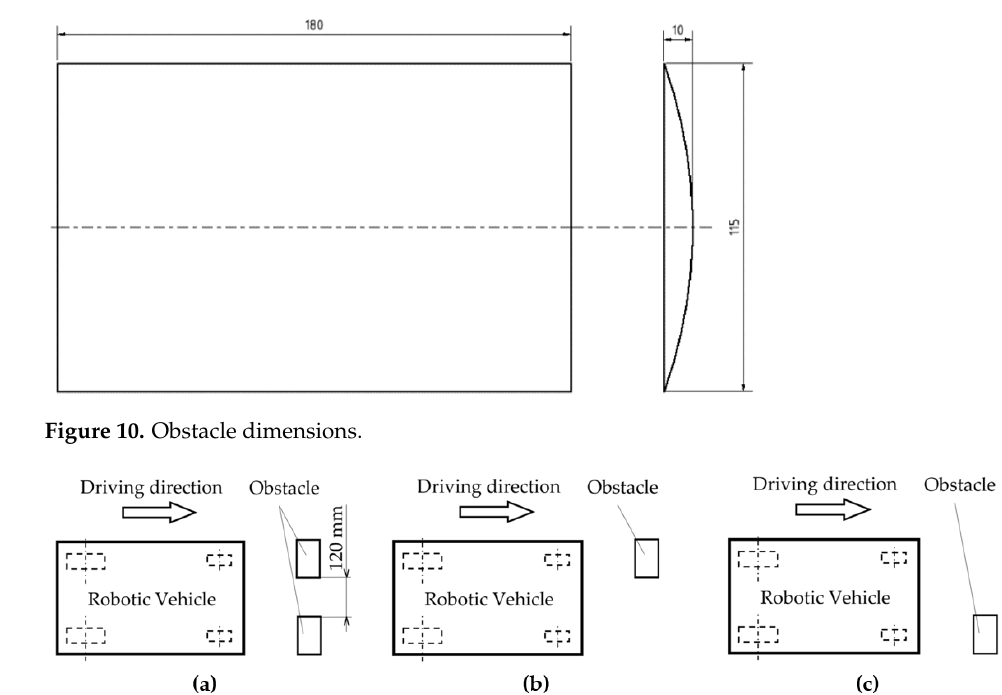
Figure 11. Obstacle variants; ( a ) symmetrically, ( b ) asymmetrically to the left, ( c ) asymmetrically to the right.